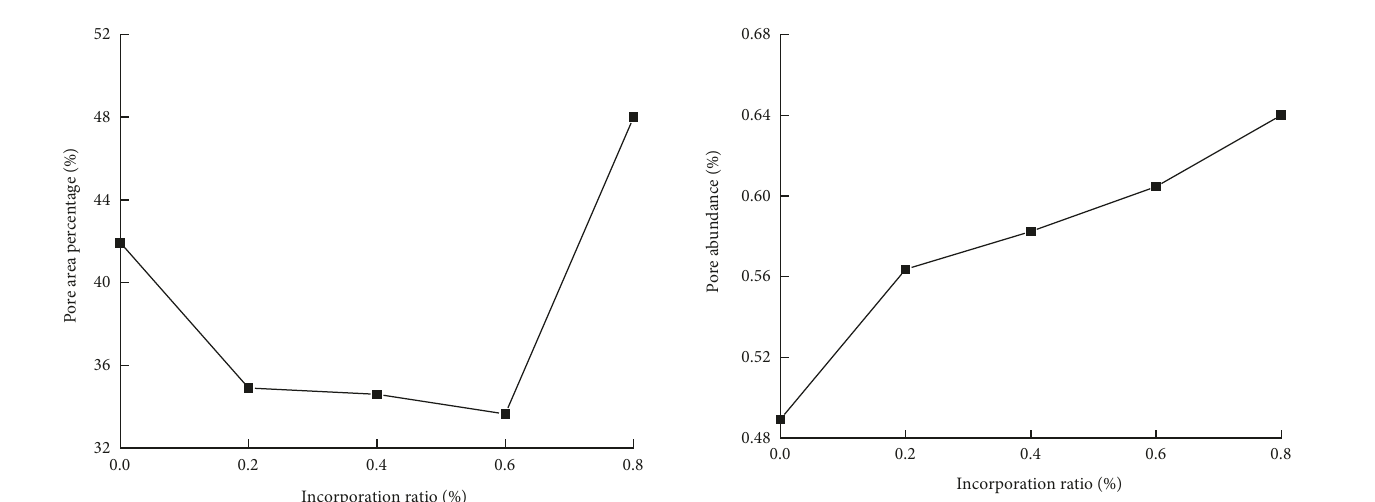
Figure 14: Pore abundance versus glass fiber incorporation